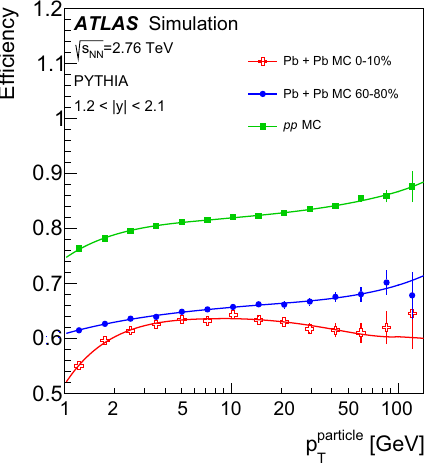
1 . 2 < | y | < 2 . 1 ( right ). Efficiency is shown for central and peripheral Pb+Pb collisions as well as for pp collisions. The full line represents the parameterisation (for more details see the body of the text)